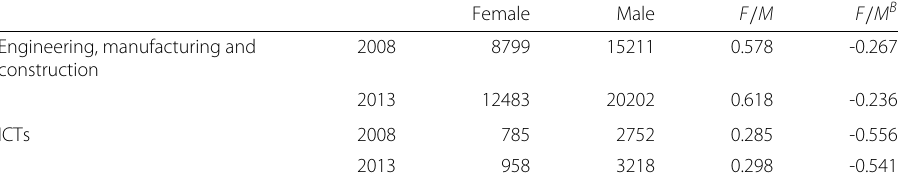
Table 1 Number of female and male students, F / M ratio and F / M B measure for the overall mobility in the male-intensive fields of